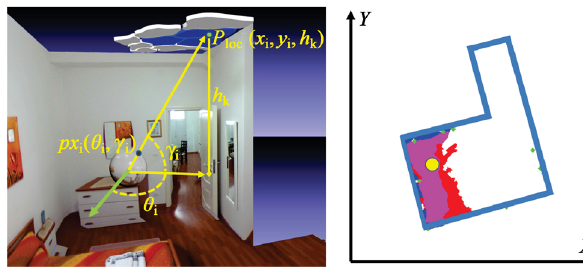
Fig. 3 3D facets from super-pixels. Left: from a pixel px i ( θ i ,γ i ) ( θ and γ are angles relative to the direction of the image center, the green arrow) we obtain a point P loc ( x i ,y i ,h k ) in world space using Eq. (2). As a result, super-pixel points generate horizontal facets in world space (here, blue ceiling facets). Right: labeled super-pixels from Fig. 2 transformed to facets and projected on the x – y plane. Magenta zones represent the overlap between ceiling and floor projections, the yellow point is the camera position, and the azure contour is the underlying shape of the